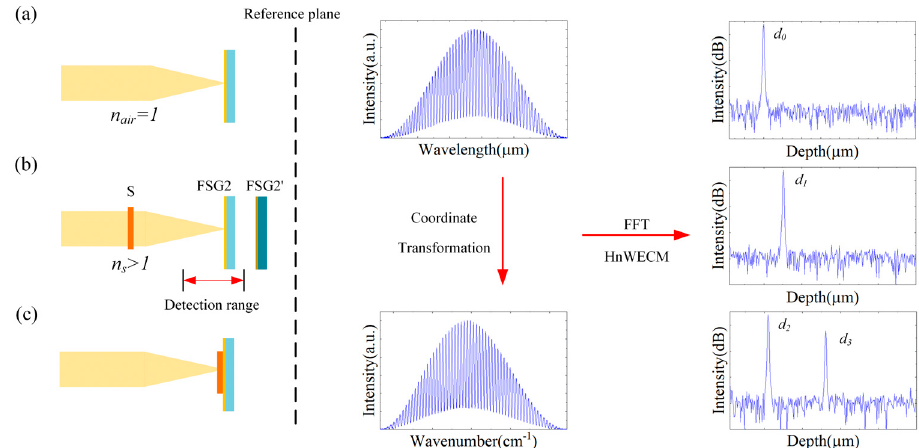
Figure 3. Inspection schematic diagram: ( a ) the interferometric signal and FFT result of FSG2; ( b ) the interferometric signal and FFT result of FSG2 after inserting the liner into the probe beam; ( c ) the surface and inner layer of the liner.